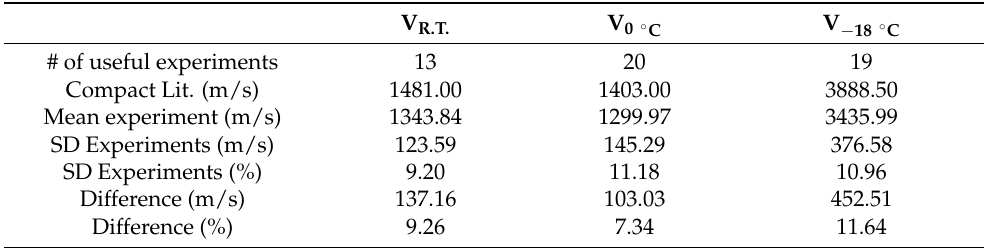
Table 4. Ultrasonic velocity values of porous drop experiments compared with literature values of “compact” liquid water and ice with no bubbles [25]. The mean values and the standard deviations (SD) are